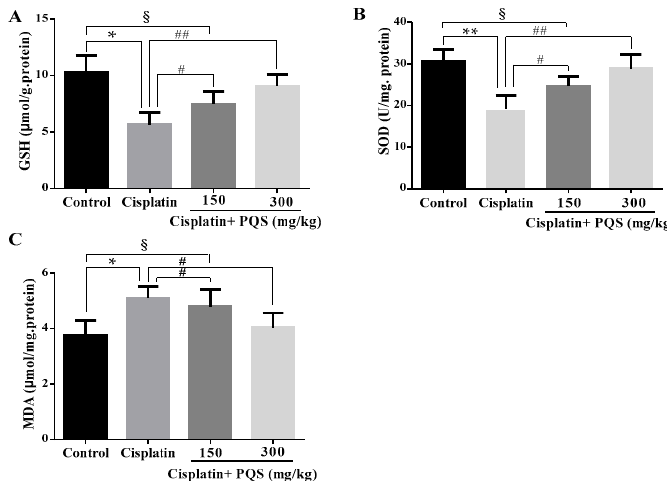
Figure 2. Effects of PQS on the levels of: glutathione (GSH) ( A ); superoxide dismutase (SOD) ( B ); and malondialdehyde (MDA) ( C ) in cisplatin-induced AKI. All data are expressed as mean ± S.D., n = 8. § p < 0.05, * p < 0.05, ** p < 0.01 vs. control group; # p < 0.05, ## p < 0.01 vs. cisplatin group.